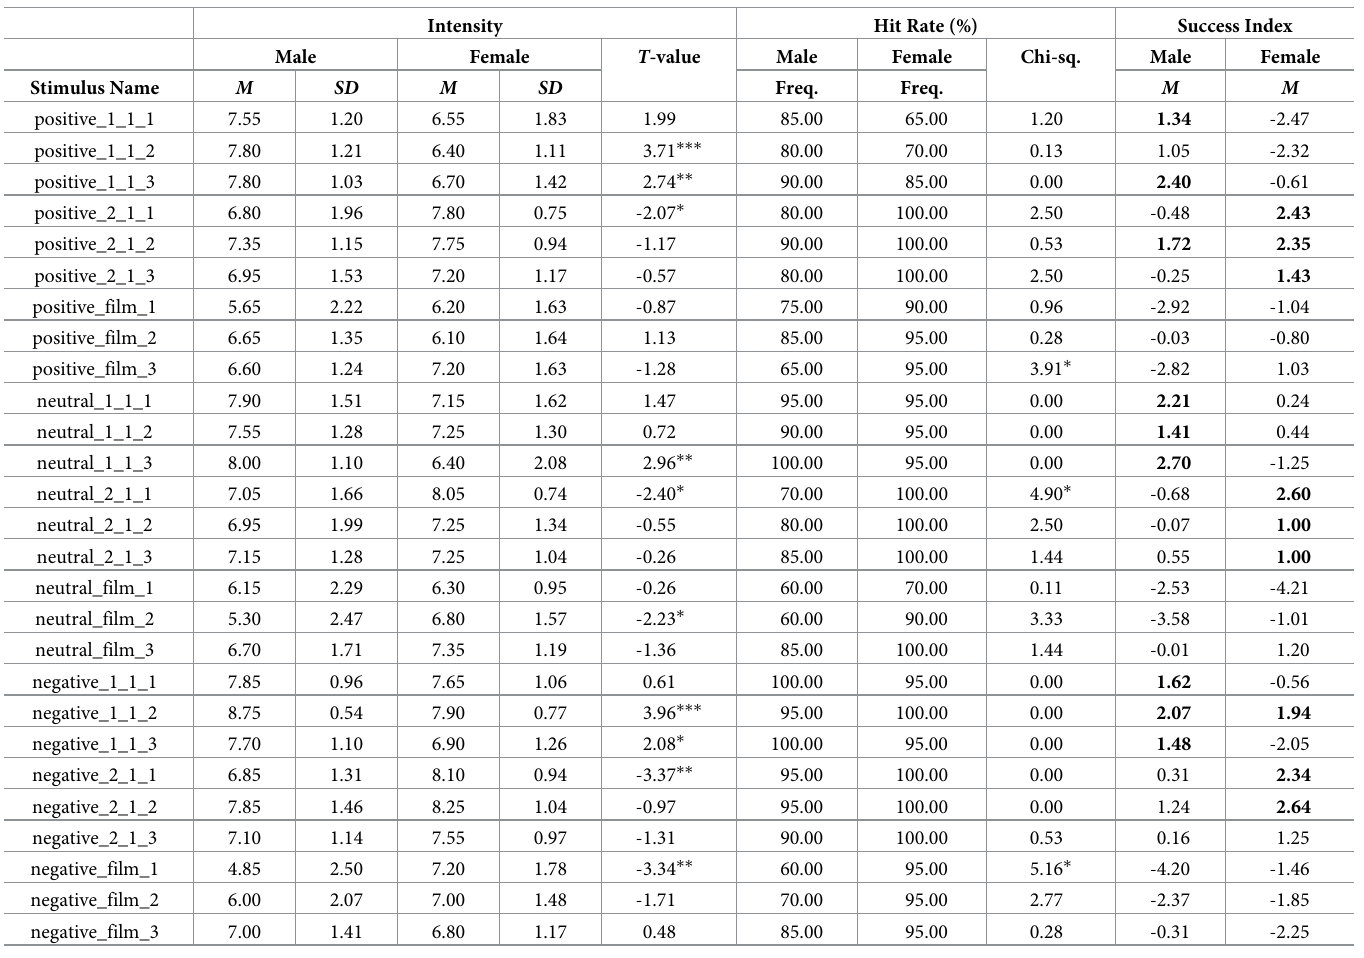
Table 4. The statistical analysis results on emotional evaluation scale of male and female groups aged